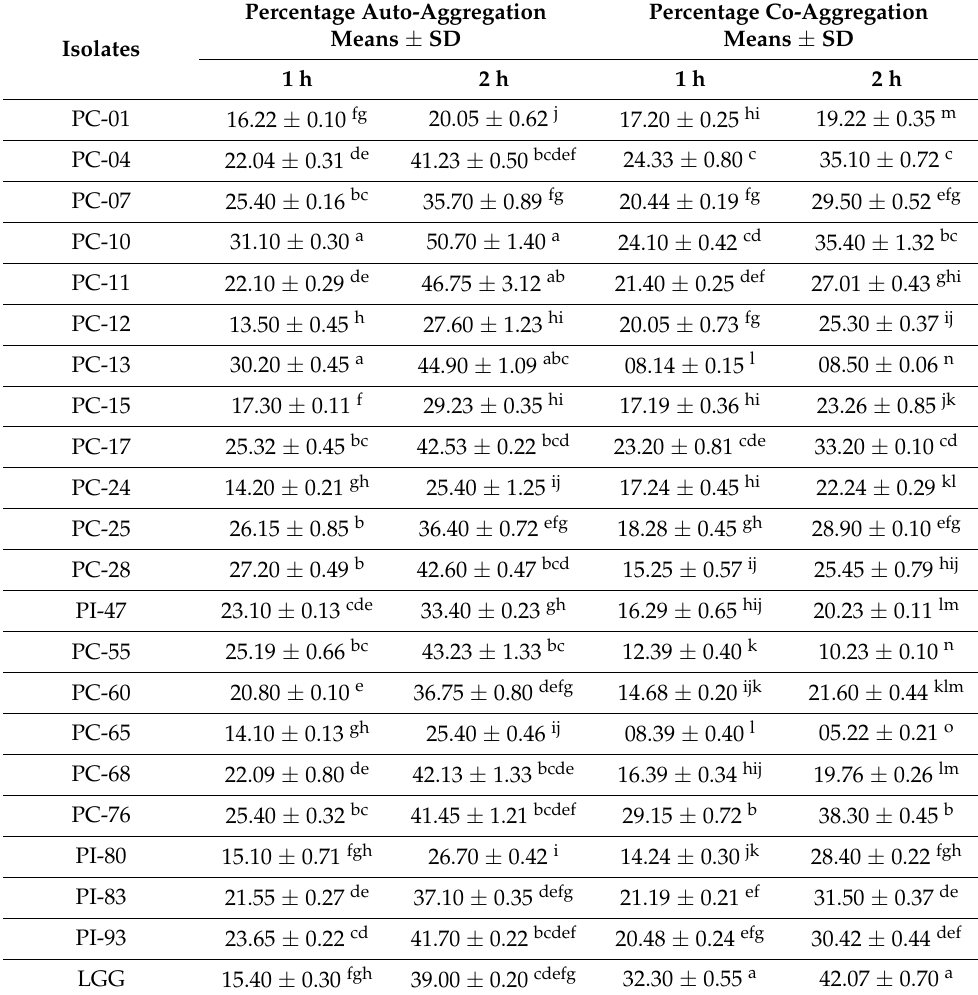
Table 2. Auto-aggregation and co-aggregation activity of lactobacilli at different time intervals. Percentage Auto-Aggregation Percentage Means ± SD Isolates